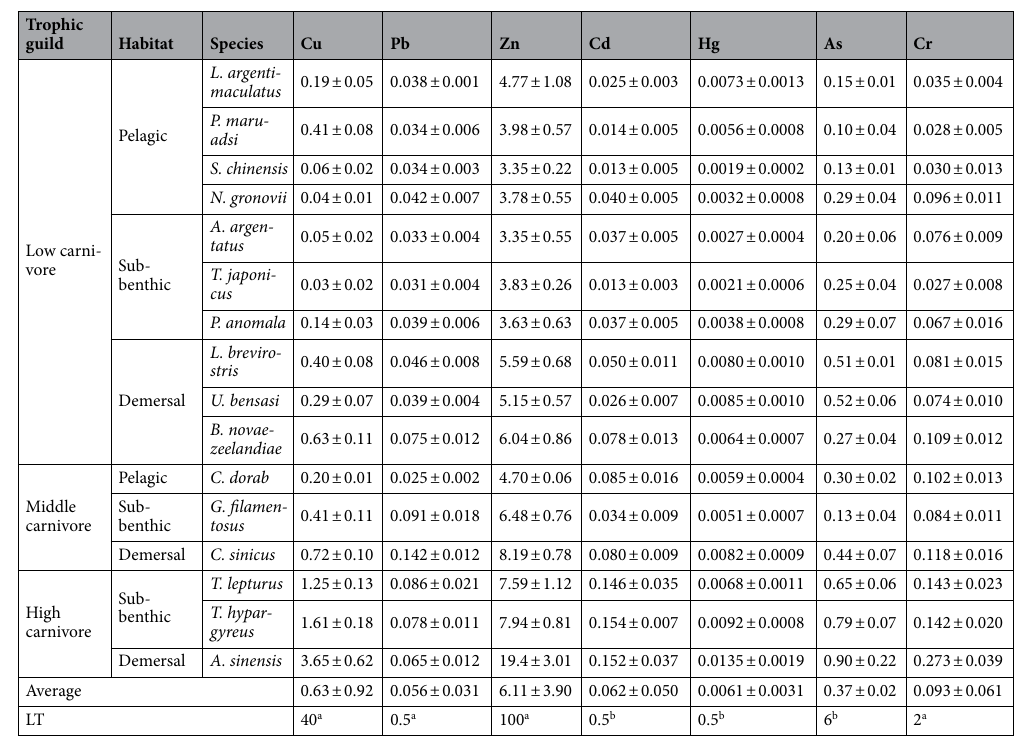
Table 1. Trace metal contents (µg·g −1 , w.w.) in sixteen fish species (mean ± SD) collected from Xincun Lagoon, South China Sea and the legislation thresholds (LT). a China National Standards (2017). b European Commission